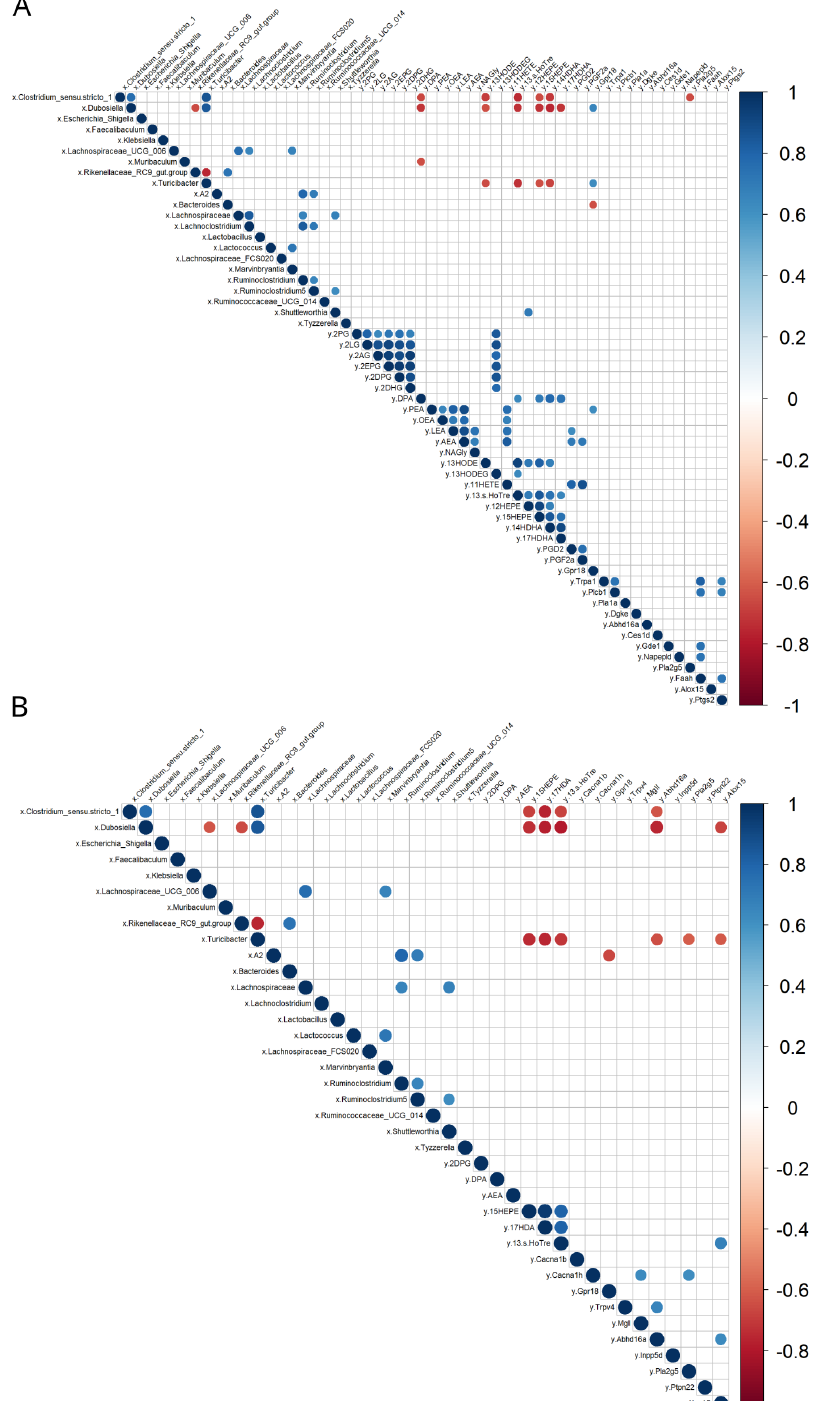
Figure 6. Correlation plot between altered fecal bacterial taxa and eCBome ‐ related mediators measured in two gut segments (i.e., the duodenum and distal colon). ( A ) Correlation matrix showing Spearman correlations with Holm’s adjustment in the duodenum; ( B ) Correlation matrix showing Spearman correlations with Holm’s adjustment in the distal colon. Positive correlations are displayed in blue and negative correlations in red. Color intensity and size of the circles are proportional to the correlation coefficients. “X” refers to the first data set, the fecal bacterial taxa, while “Y” refers to the second data set, the eCBome ‐ related mediators and mRNAs measured in the two respective gut segments.